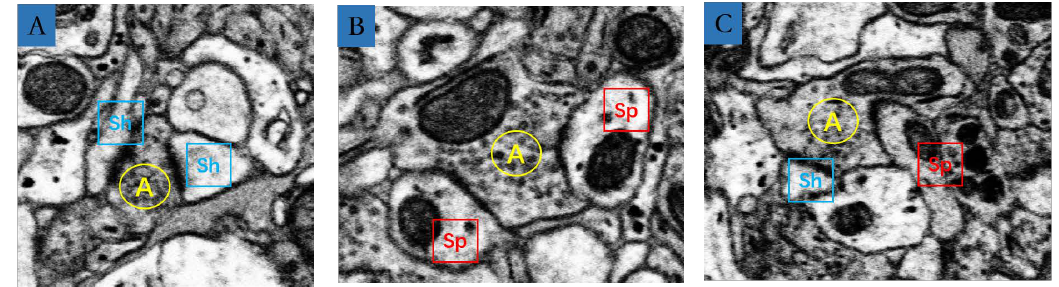
Figure 15. Three types of MSBs. ( A ) Axon-multiple dendritic shaft synapse; ( B )axon-multiple dendritic spine synapse; ( C ) axon-dendritic shafts-dendritic spine; where the A in yellow is the axon, Sh in blue is the dendritic shaft, and Sp in red is the dendritic spine.)